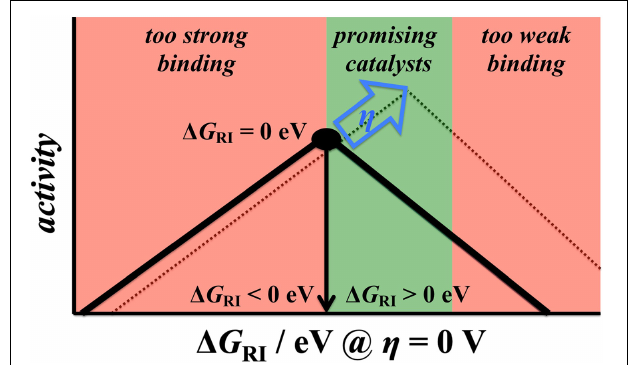
FIGURE 7 | The extended Sabatier principle purports a positive shift of the reaction intermediate’s optimum binding energy with increasing driving force for a two-electron process. As such, electrocatalysts that bind the intermediate slightly weakly (by about 100 – 200 meV) are the most promising materials. Reproduced from Exner (2020c) with permission. Copyright 2020 John Wiley and